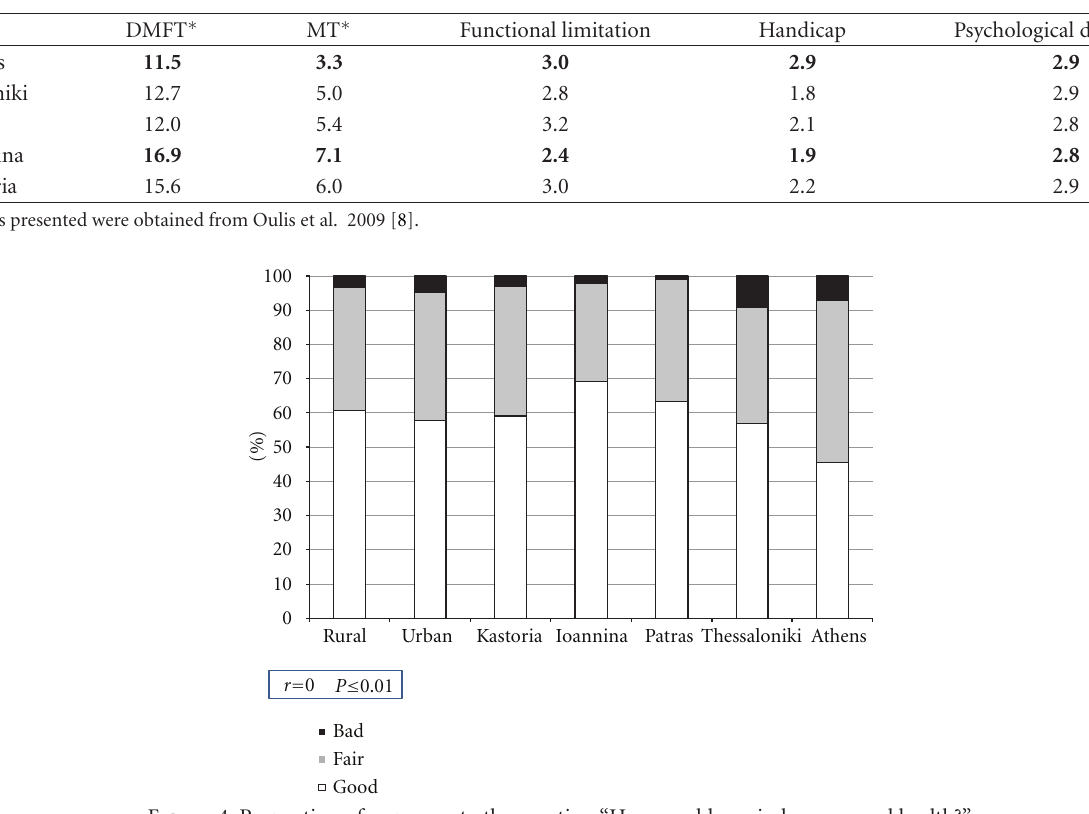
Figure 4: Proportion of responses to the question “How would you judge your oral